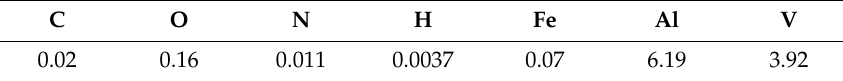
Table 1. Chemical composition of the wire material employed (wt